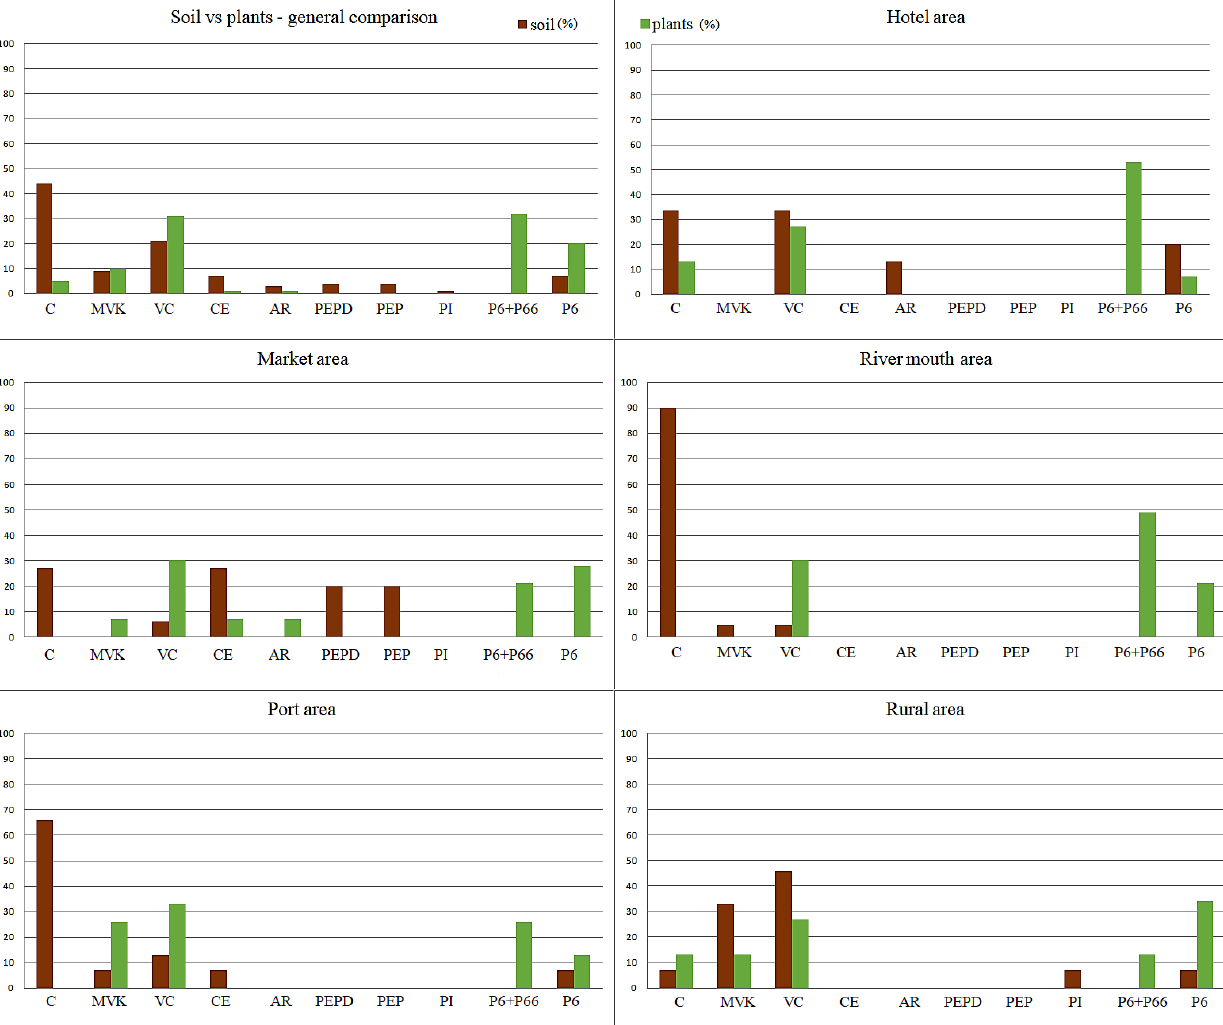
Figure 4. Percentages of polymers identified in the overall spectra of soil and plant (pneumato- phore) samples (general comparison), and in the particular experimental areas.